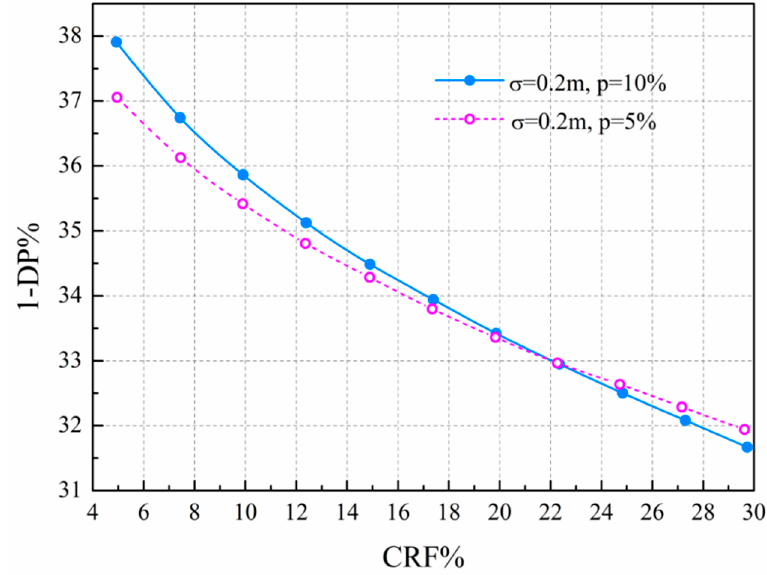
Figure 9. Relationship between cumulative rate of false alarm and rate of missing detection. (Each STWL was tested for 24 different start times, and the vertical coordinate value of the point in Figure 7 and Figure 8 is the average of 24 different DPs. Figure 9 utilizes a similar processing method to obtain an average of 24 1-DPs when selecting the optimal solution of STWL.)